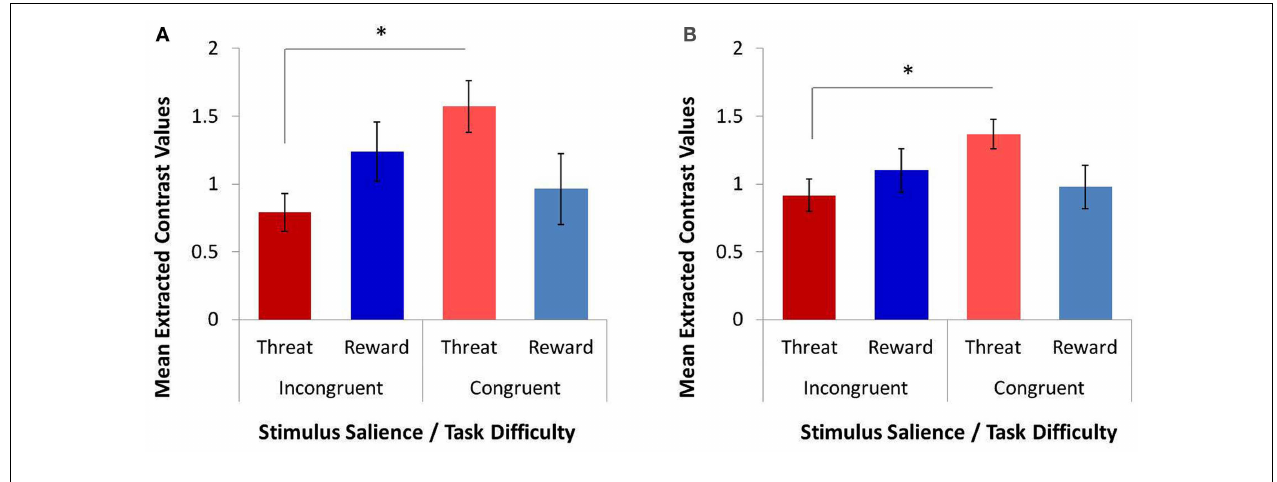
amygdala (B) .The amygdala response to threat distracters on the more demanding incongruent trials was significantly lower than to threat distracters on the easier congruent trials. In contrast, the amygdala response to reward distracters was not modulated by task difficulty. * p <